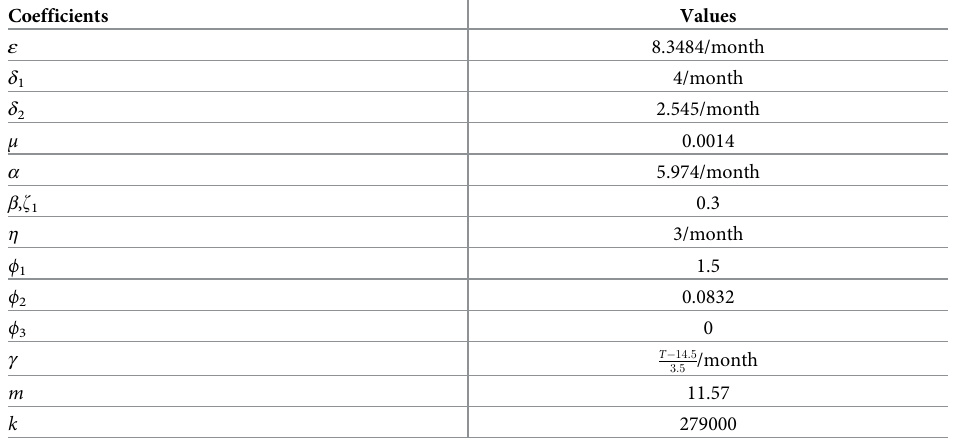
Table 2. Model coefficients obtained directly or estimated from Wyse et al. [27] and Detinova et al. [32].